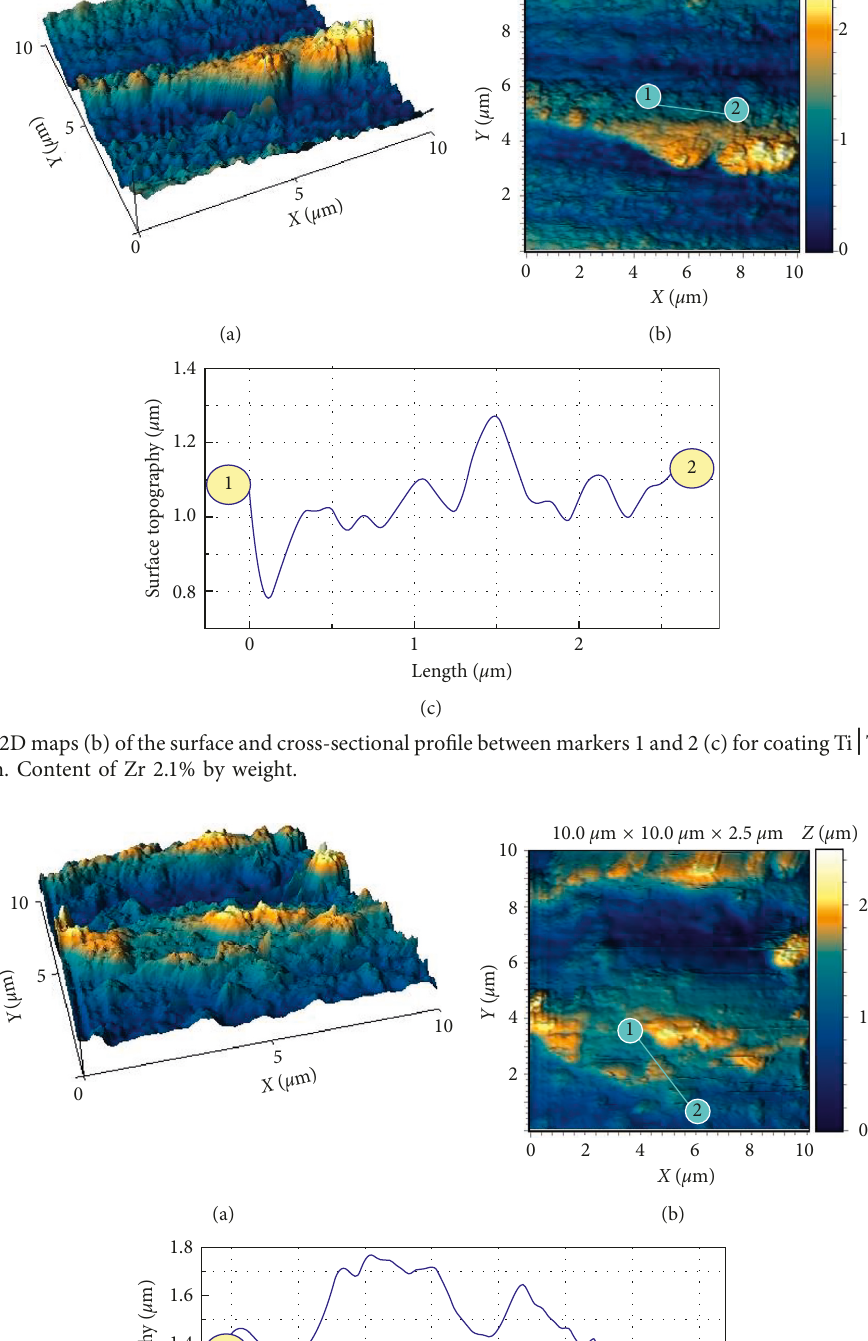
2 · ZrO 2 coating after